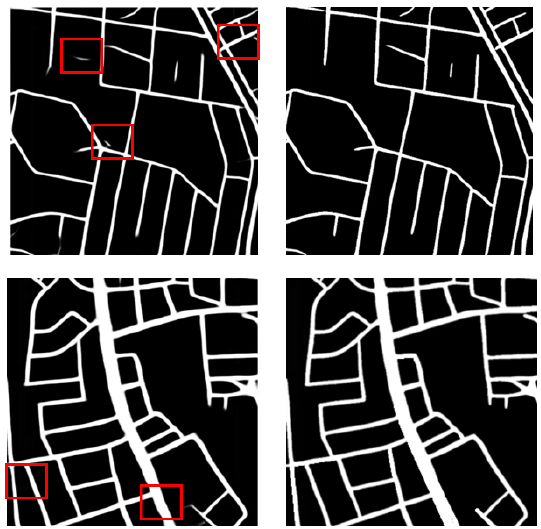
Figure 11. Road Extraction Results Before and After Post-processing.